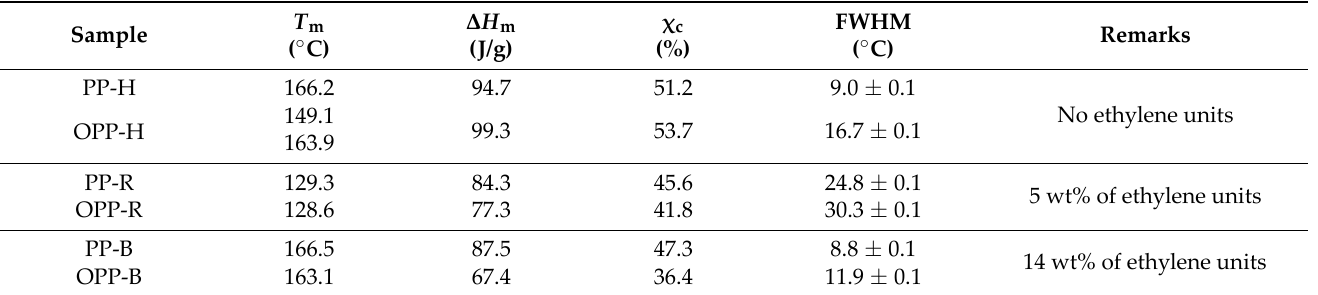
Table 2. Thermal properties of PP granules (homopolymer, random, and block copolymers) before and after oxidation: T m , ∆ H m , χ c .